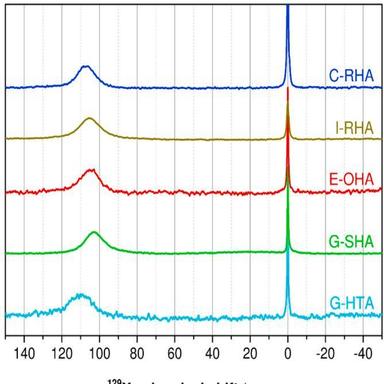
129Xe NMR spectra of biogenic silica; C-/I-RHA: rice husk ash (Cambodia/Italy), E-OHA: oat husk ash (Europe), G-SHA: spelt husk ash (Germany), G-HTA: horsetail ash (Germany).